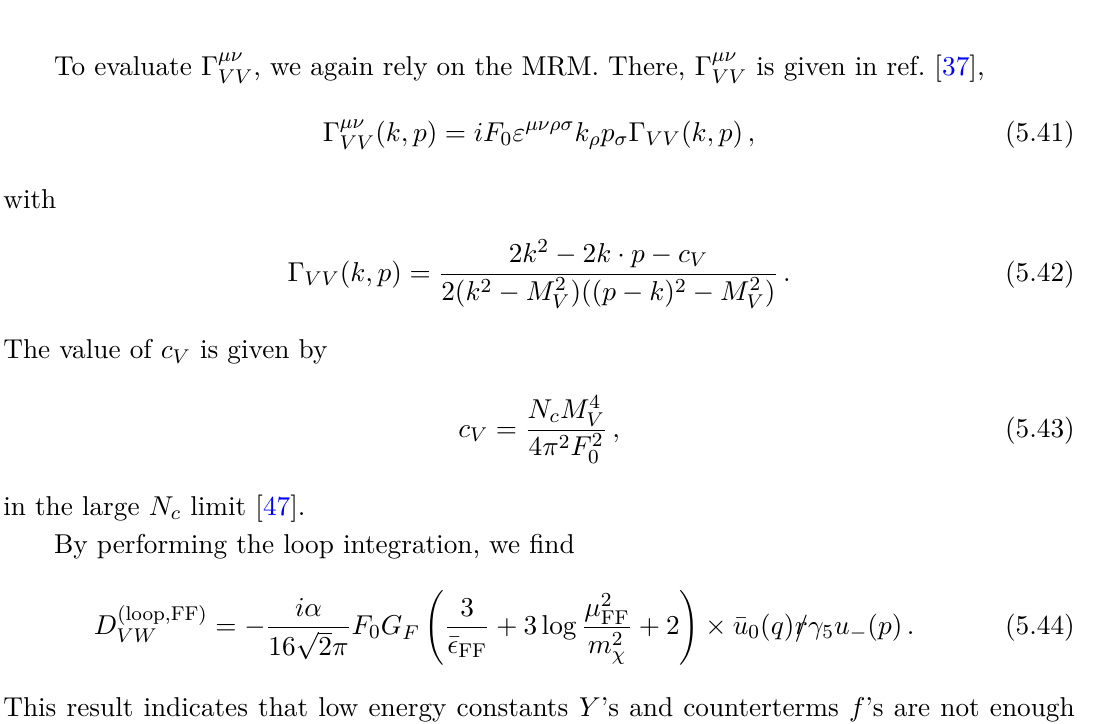
Figure 13 . The one-loop contribution to D V W in the Four-Fermi theory. The double line denotes ◦ the current correlator Γ µν . The points (cid:4) and are the separated vertices proportional to q 1 V V and q 8 ∗ ( x ) , W